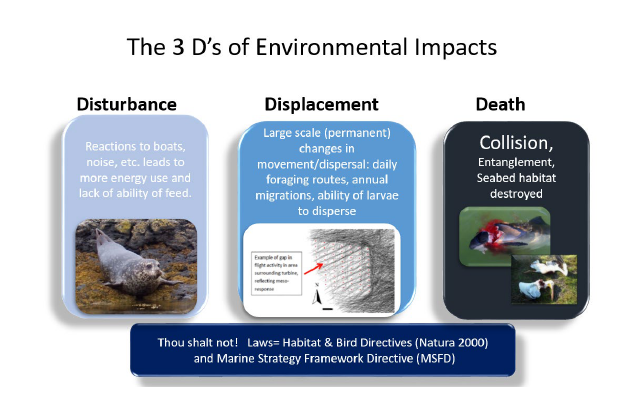
Fig. 1. The 3Ds of Environmental Impacts and the international policies that cover